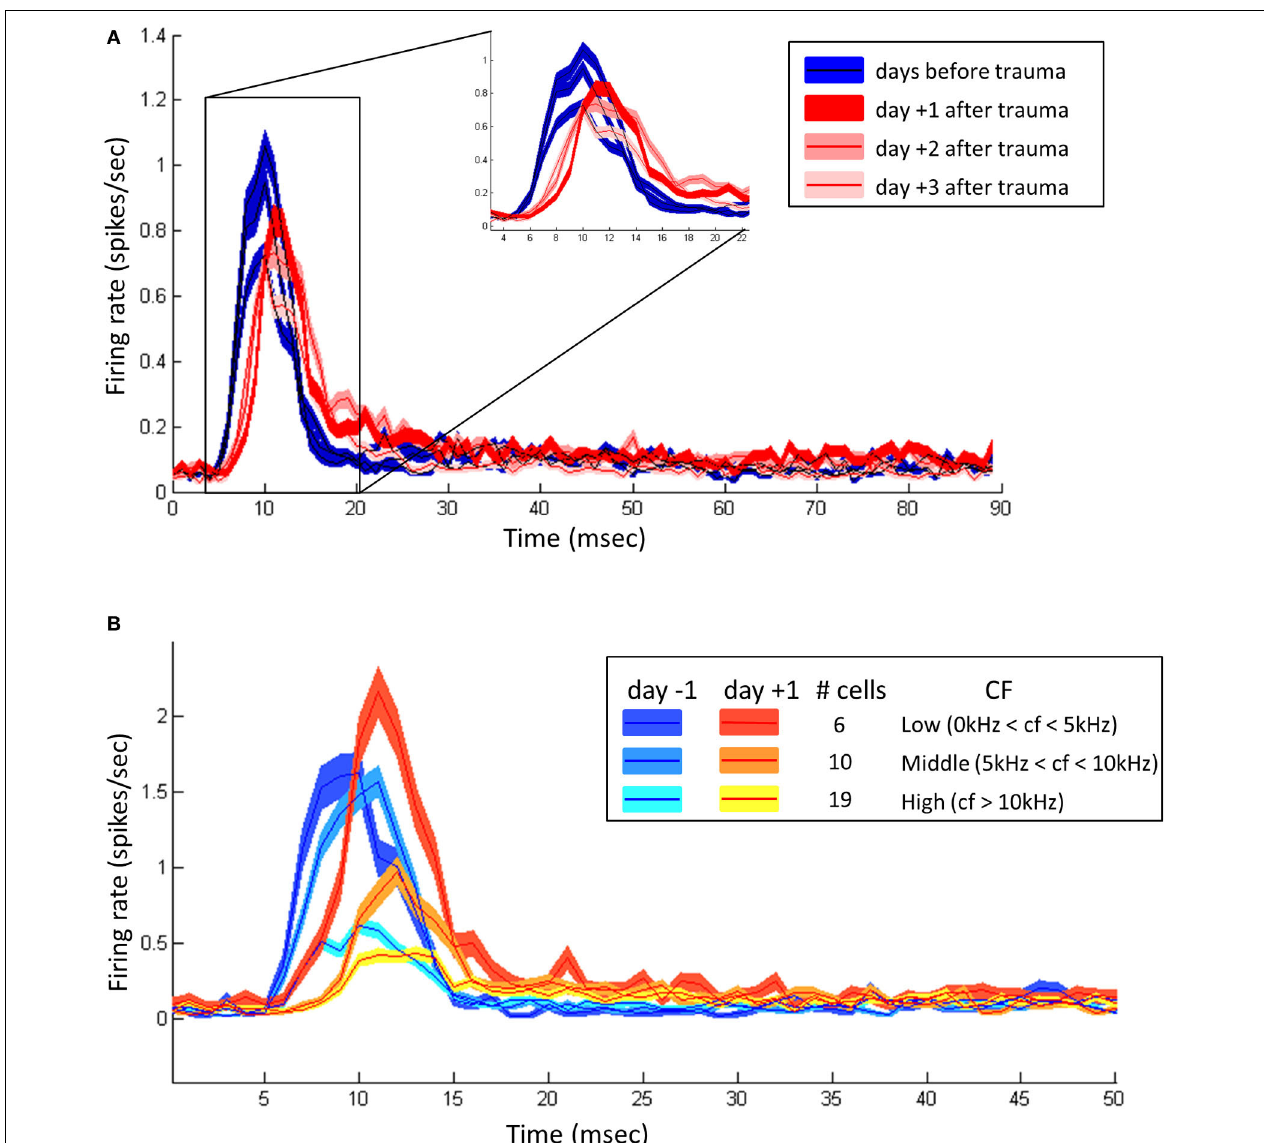
FIGURE 7 | Impact of hearing loss on the latency and duration of the responses to vocalizations. (A) Onset Post Stimulus Time Histograms (PSTHs) computed from the responses to the three vocalizations and their time-reversed versions. The blue curves represent the onset PSTHs recorded the 3 days before the trauma (control). The